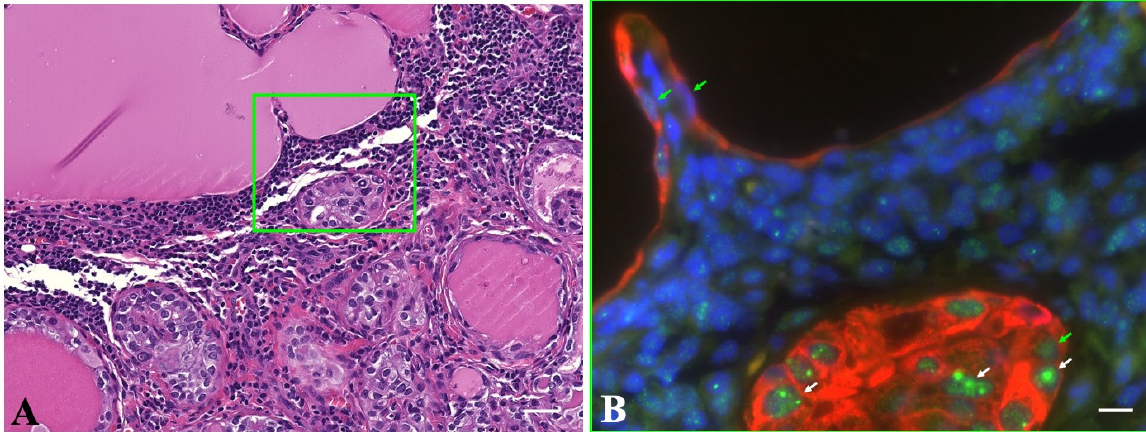
Figure 3. Double immunofluorescence for p53-binding protein 1 (53BP1) (green) and pan-cytokeratin (AE1/AE3) (red) expression to detect follicular epithelium in a cervical lymph node from a papillary thyroid carcinoma (PTC) case. It exhibits both metastatic PTC (lower part) and thyroid follicular inclusion (TFI) without PTC-like nuclear features (NFs) (upper part) ( A ). In ( B ), surrounded by a green square in ( A ), a metastatic PTC shows the DNA damage response type with two or more discrete nuclear foci, whereas the TFI without PTC-like NFs shows a stable type and lymphocytes in the background. In ( B ), the white and green arrows indicate the DDR and stable types of 53BP1 expression, respectively. The scale bars indicate 30 µ m and 10 µ m in ( A , B ),